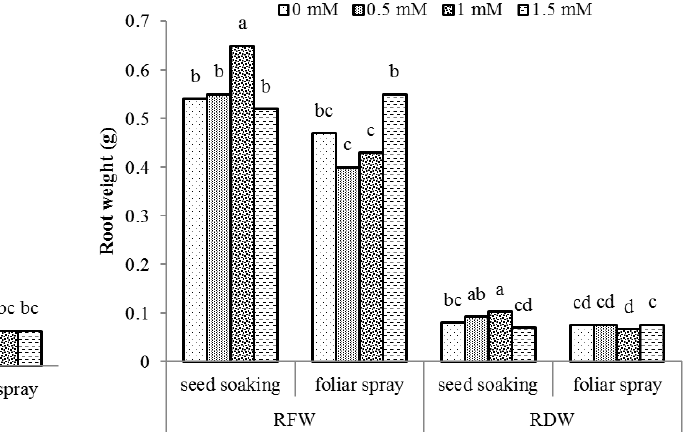
Fig. 2. Effect of SA and its application method on root fresh weight (RFW) and root dry weight (RDW) of watermelon seedling subjected to chilling stress. Values followed by different letters were significant difference according to Duncan’s Mul- tiple Range Test at p